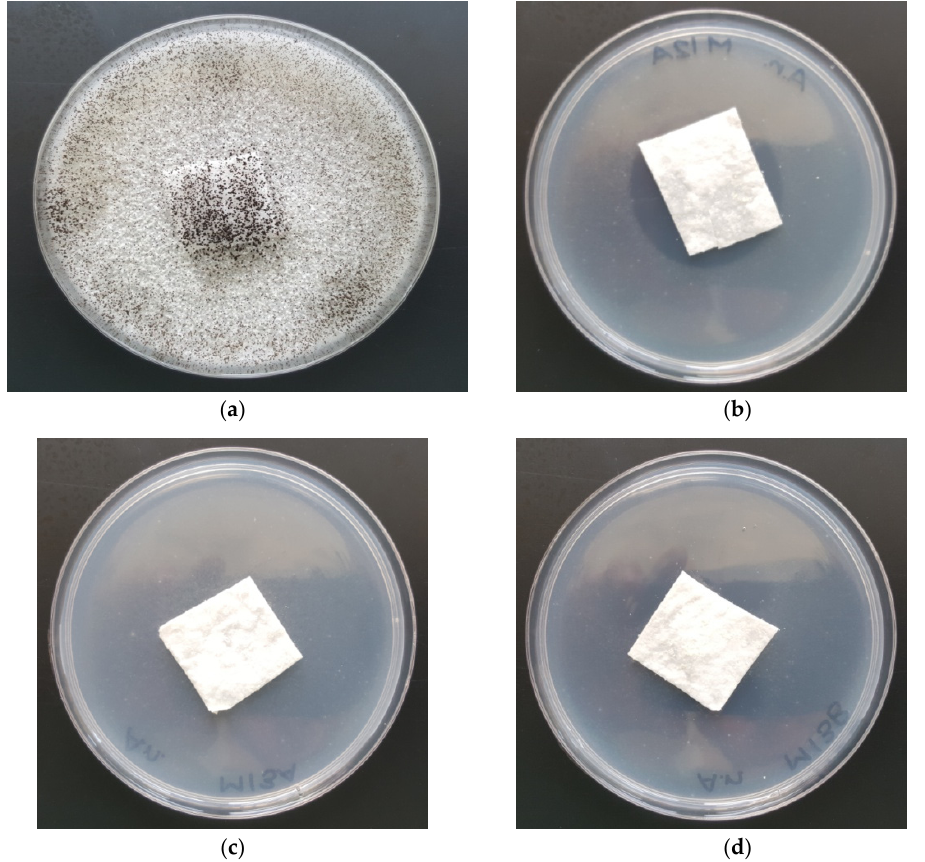
Figure 11. The antimicrobial activity tests of PLA-SM and PLA-SM-KI composites against Aspergillus niger. Inhibition zones of bacterial growth on Petri dishes. PLA-SM-KI composites (with KI coating paste concentrations: 0%, 0.1%, 1% and 2%): ( a ) PLA-SM; ( b ) PLA-SM-KI (KI = 0.1%); ( c ) PLA-SM-KI (KI = 1%); ( d ) PLA-SM-KI (KI = 2%).